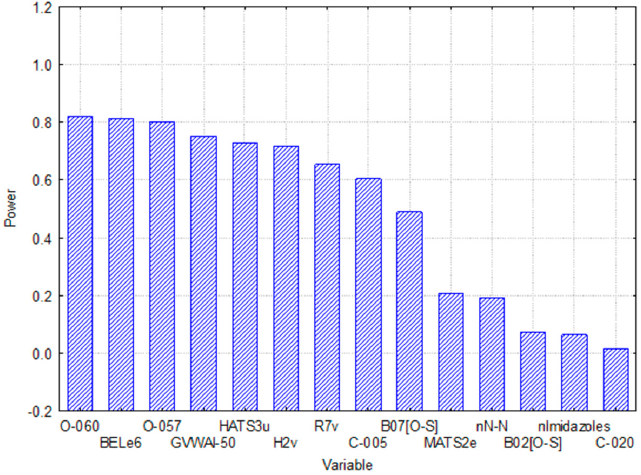
Figure 4 . Diagram of variable importance according to the PCA.